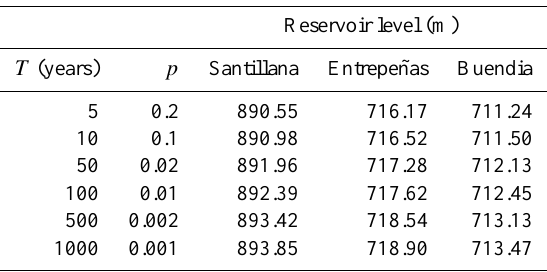
Table 5. Reservoir levels for different return periods ( T ) and ex- ceedance probabilities ( p